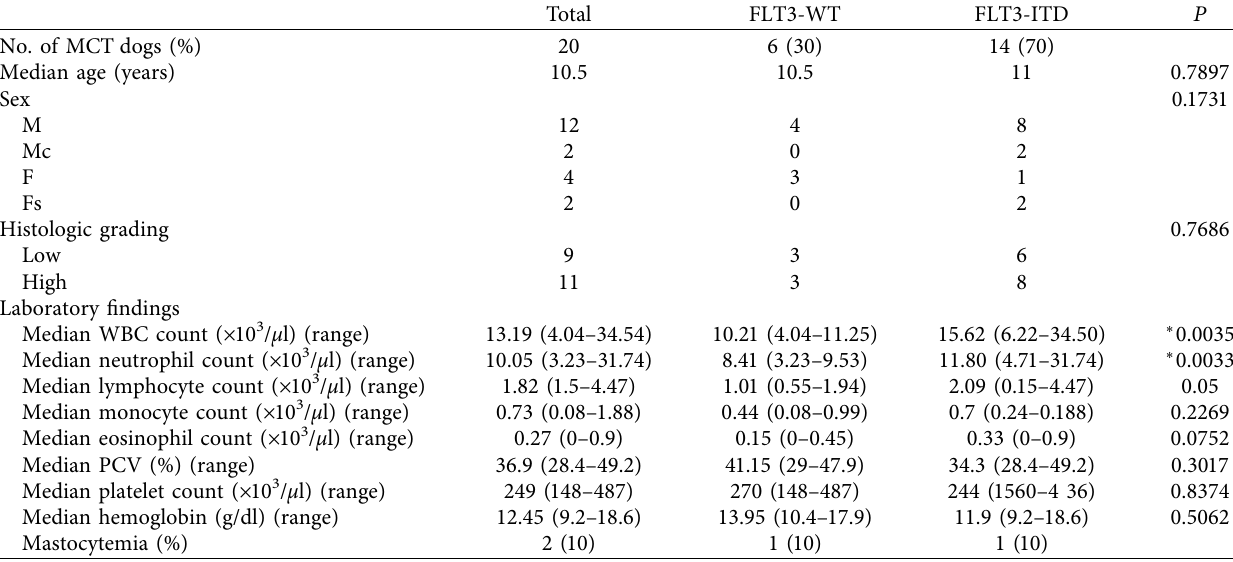
Table 3: Comparison of clinicopathological characteristics between FLT3-ITD mutation and FLT3-WTof JM domain from 20 MCTdogs at the time of